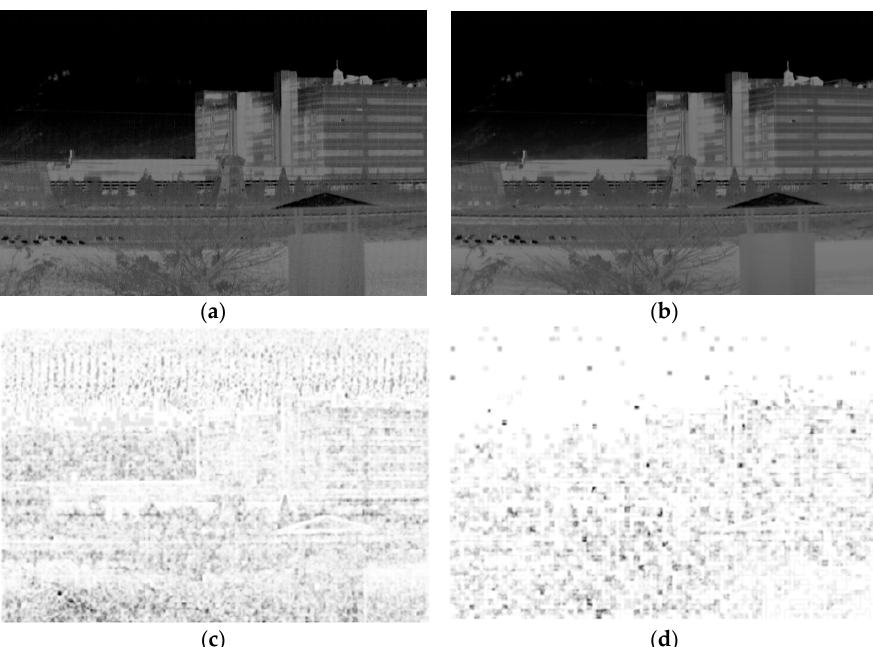
Figure 8. Noise-measurement variant structural similarity (VSSIM) index: ( a ) original noisy image; ( b ) denoised image; ( c ) noise map of the original noisy image (VSSIM = 0.8814); ( d ) noise map of denoised image (VSSIM = 0.9947).